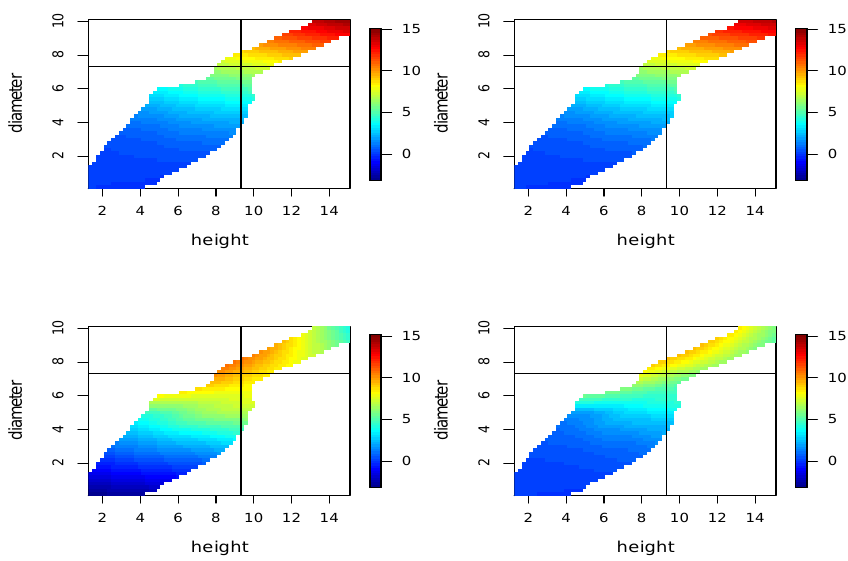
Figure 7. Fit and prediction with the S-ANOVA model ( top left ), with the S-ANOVA model, imposing that the fit is maintained ( top right ), with the 2D interaction P-spline model ( bottom left ) and with the 2D interaction P-spline models imposing that the fit is maintained ( bottom right ) at out-of-sample values of diameter [ 7.3,10 ] and height [ 9.32,15 ]